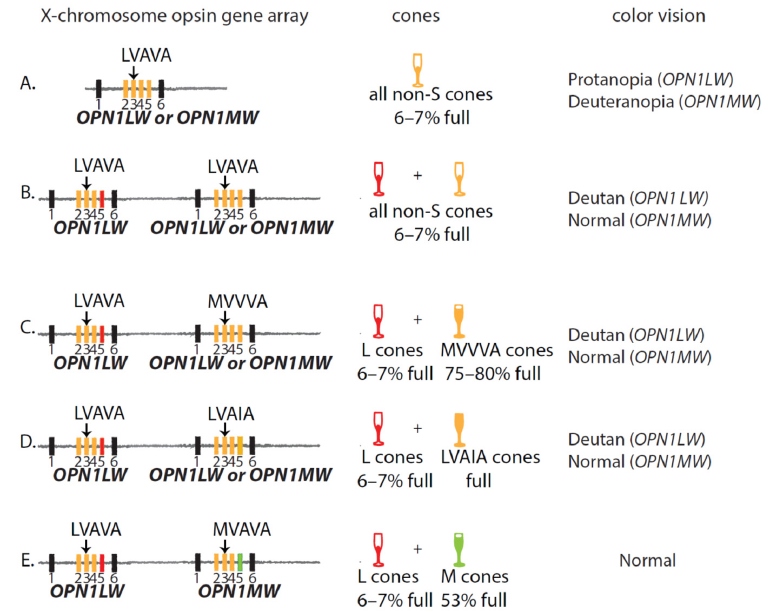
Figure 4. Opsin gene arrays with LVAVA haplotype and the associated color vision. Rectangles represent exons; see Figures 2 and 3 for a description of the color-coding. For example, the yellow rectangle representing exon 5 indicates the gene may be OPN1LW or OPN1MW . ( A ) Array with a